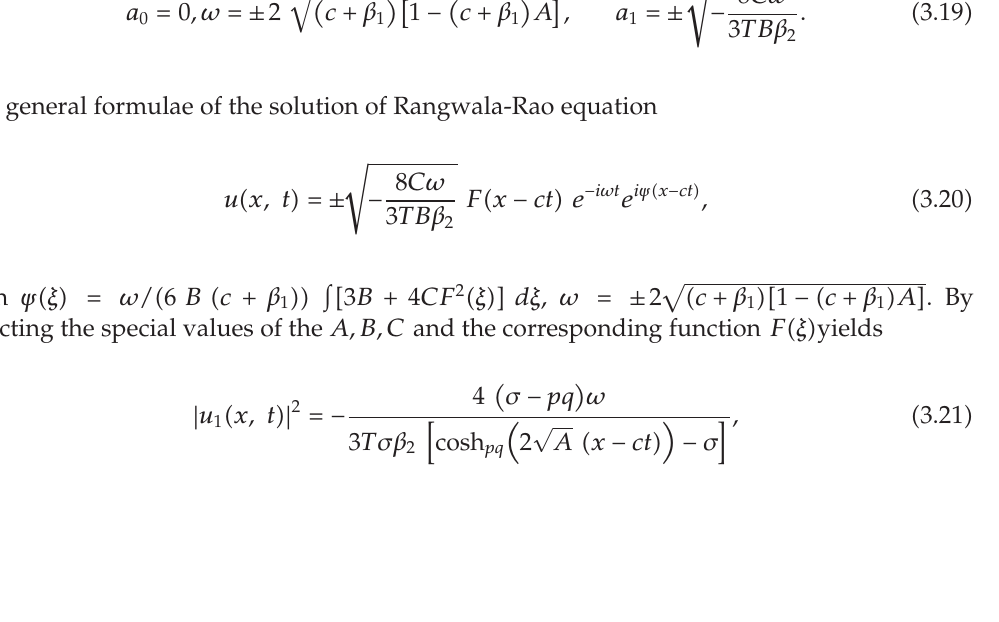
Substituting (cid:3) 3.18 (cid:4) with (cid:3) 2.5 (cid:4) into (cid:3) 3.17 (cid:4) and equating each of the coe ffi cients of F (cid:3) ξ (cid:4) to